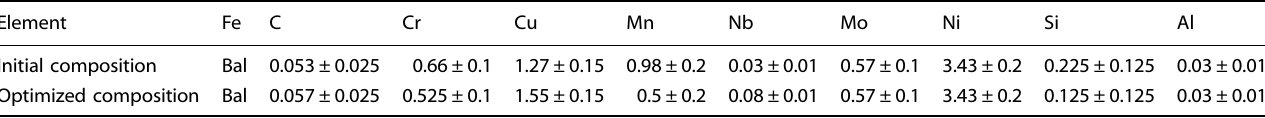
Table 3. Comparison of initial composition and optimized composition (wt%). Element